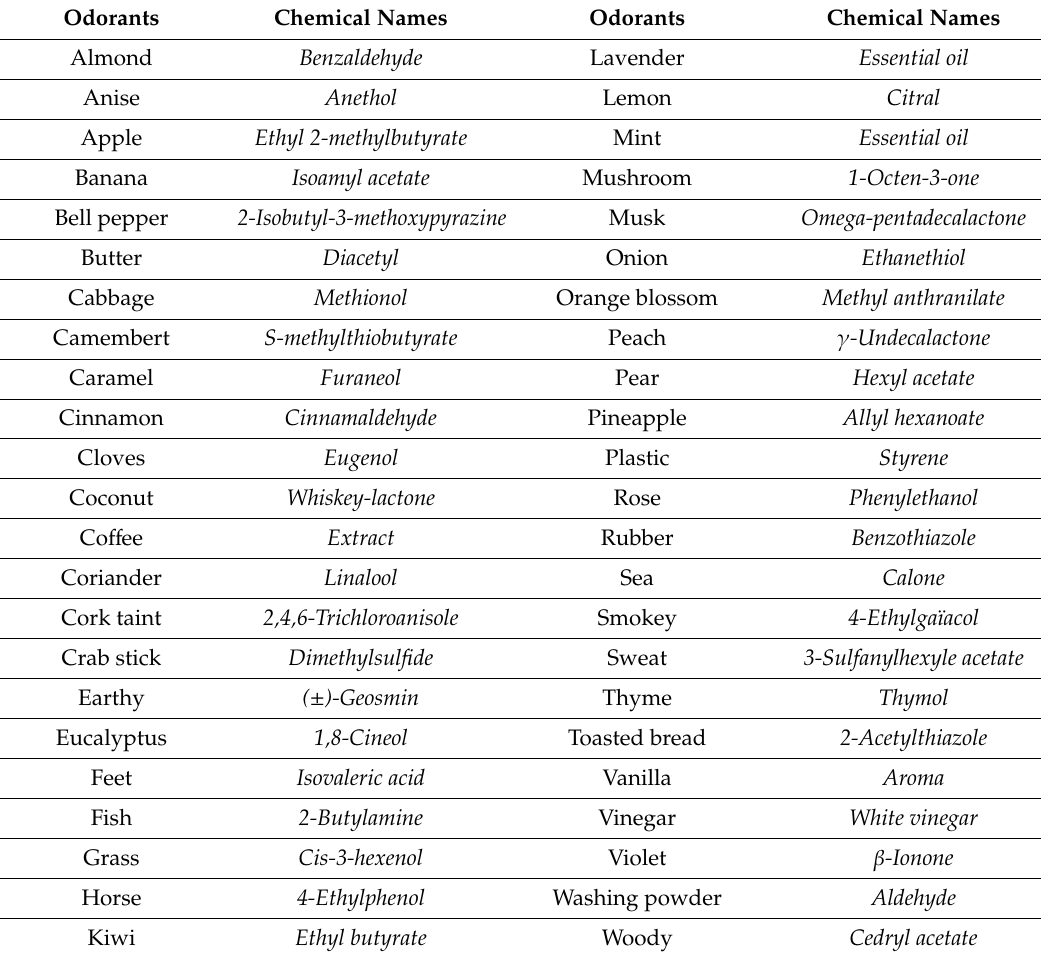
Table 6. List of odorants and respective chemical